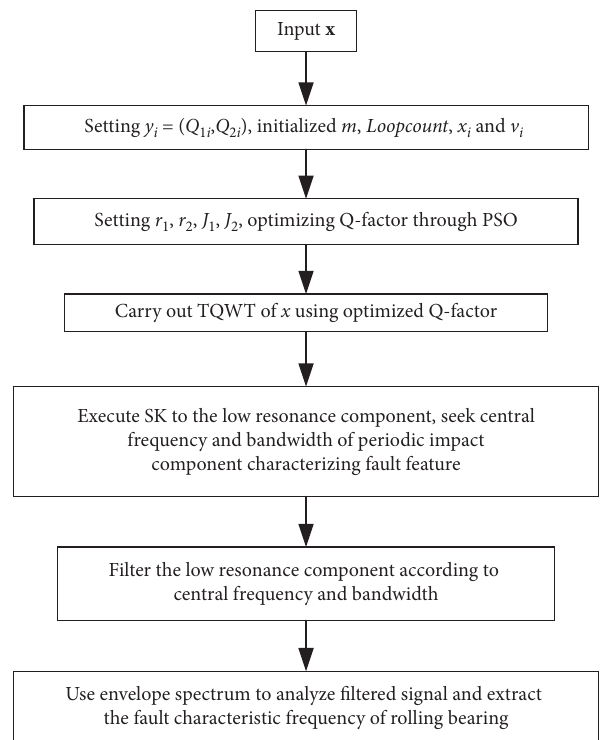
Figure 2: The flow chart of ATQWT and